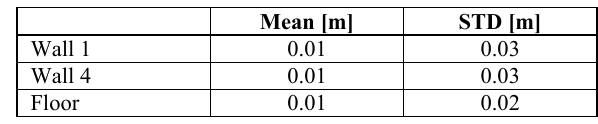
Table 2. Statistical results of surface